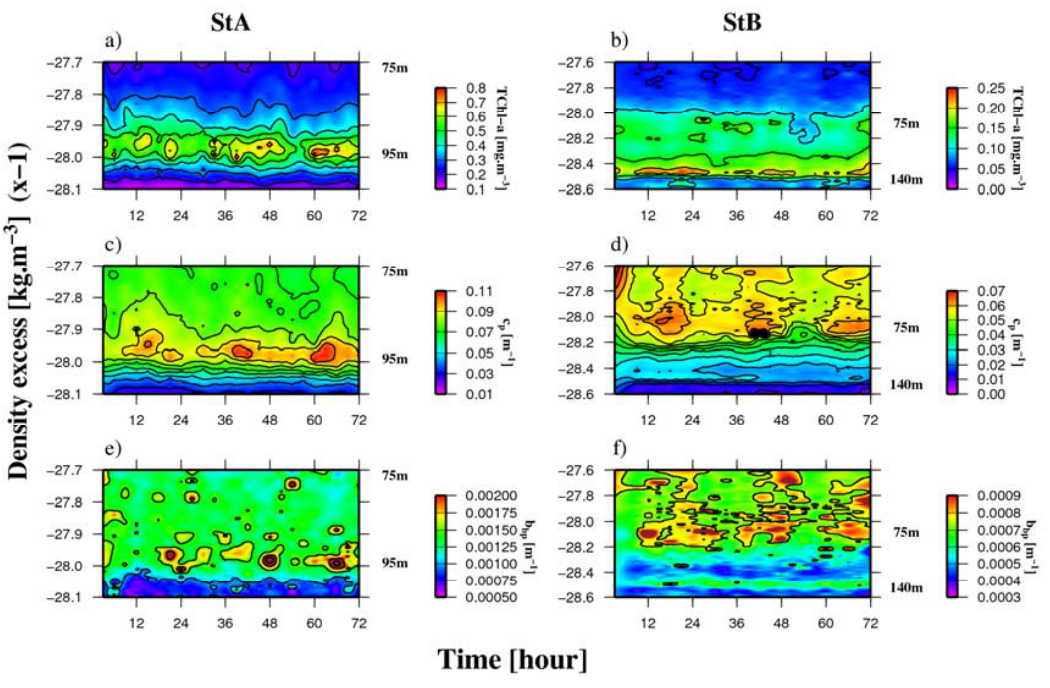
Fig. 11. Contour plot showing the vertical and temporal evolution of the chlorophyll fluorescence ( a , b ) of the particle attenuation coefficient, Figure 11. c p , (m − 1 ) , ( c , d ) and of the particle backscattering coefficient, b bp , (m − 1 ) ( e , f ) at stations A and B respectively. The vertical dimension is represented in terms of density in order to remove the effects of internal waves throughout the water column.